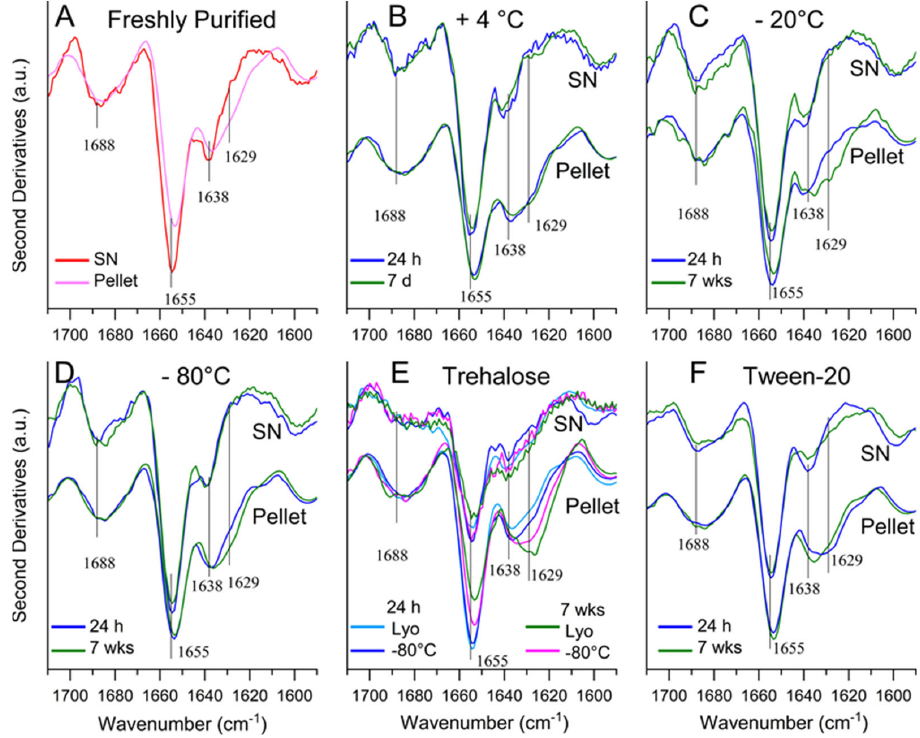
Figure 4. FTIR analysis of vault protein preparations. Samples were stored for the indicated times and under the indicated conditions, as shown in the individual panels. Then, second derivatives of the IR absorption spectra of supernatants (SN) and pellets after centrifugation at 20,000× g were analyzed. ( A ) Sample freshly eluted from the SEC column; ( B ) sample incubated at 4 ◦ C; ( C – F ) samples frozen and thawed, except for panel ( E ), wherein the sample was frozen at − 80 ◦ C in 10 mg/mL trehalose and either thawed or lyophilized and reconstituted (Lyo) before the analysis; ( F ) sample frozen at − 80 ◦ C in 0.05% Tween-20. The main peak positions are reported. Spectra of total samples (analyzed prior to centrifugation) are shown in Figure